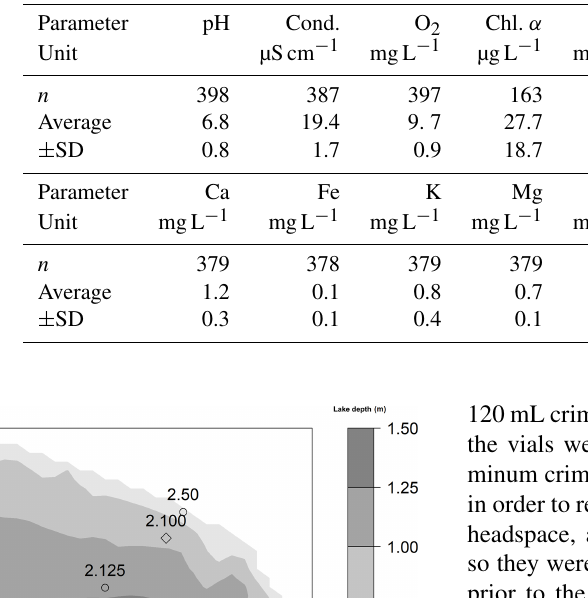
Table 1. Selected lake water characteristics measured in Lake Windsborn in 2017 and 2018: pH, conductivity (cond.), dissolved oxygen (O 2 ), chlorophyll α (Chl. α ), dissolved organic carbon (DOC), total dissolved nitrogen (TN), chloride (Cl), calcium (Ca), iron (Fe), potassium (K), magnesium (Mg), sodium (Na), phosphorous (P) and sulfur (S).